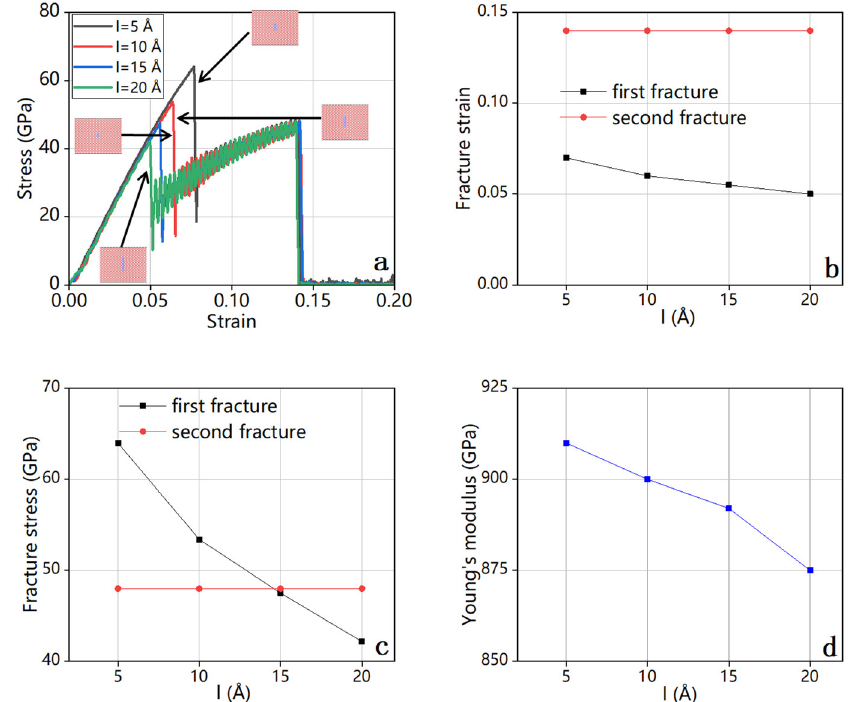
Figure 9. Rectangular cracks of varying length on a single layer: ( a ) stress–strain relationships, ( b ) fracture strain, ( c ) fracture stress, and ( d ) Young’s modulus. The double peaks are observed in the stress–strain curves, indicating a subsequent fracture of the cracked layer and the uncracked layer.